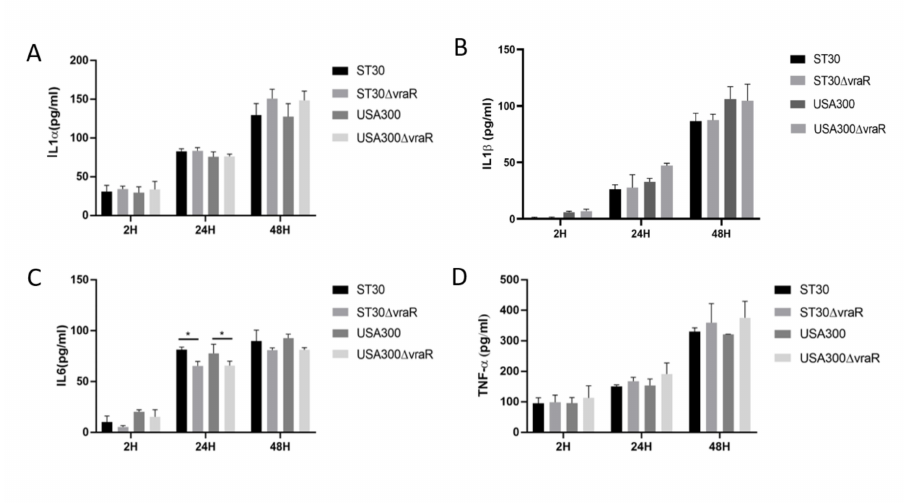
Figure 4. Cytokines IL1 α ( A ), IL1 β ( B ), IL6 ( C ), and TNF α ( D ) released by the skin model were measured at 2 h, 24 h, and 48 h, and normalized to the values measured for the uninfected skin model. The error bars represent the standard deviation of the mean values. Significance was determined by two-way ANOVA. Dunnett’s multiple comparison test was performed to analyze the release of cytokines by the skin model in response to each respective treatment. The p -values were obtained by comparison between the mean of the treatments of the skin model at each time point and coded as * p < 0.05.